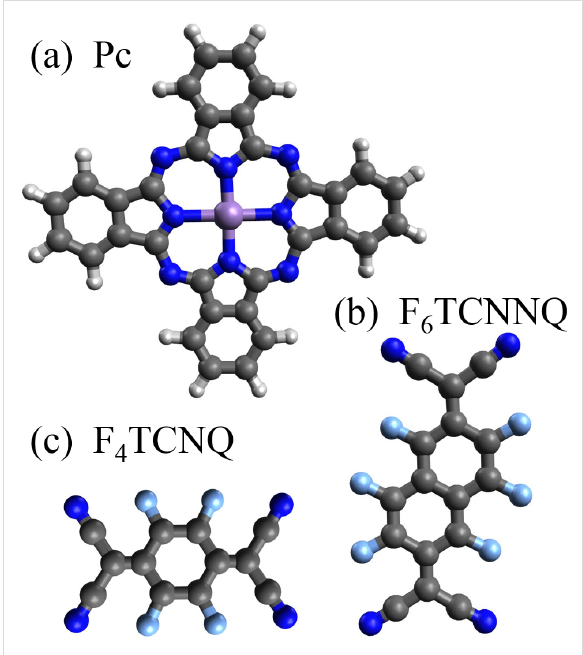
Figure 1: Molecular structure of (a) transition metal phthalocyanines, (b) 1,3,4,5,7,8-hexafluorotetracyanonaphthoquinodimethane (F 6 TCNNQ), and (c) 2,3,5,6-tetrafluoro-7,7,8,8-tetracyanoquinodi- methane (F 4 TCNQ). The transition-metal center in the phthalocyanine molecule can vary; in this work Mn and Co are relevant. Moreover, phthalocyanines can be modified by the substitution of hydrogen with fluorine atoms as in F 16 CoPc. Different atoms are shown with different colors (C: black, N: blue, H: white, F: light blue, and Mn/Co: